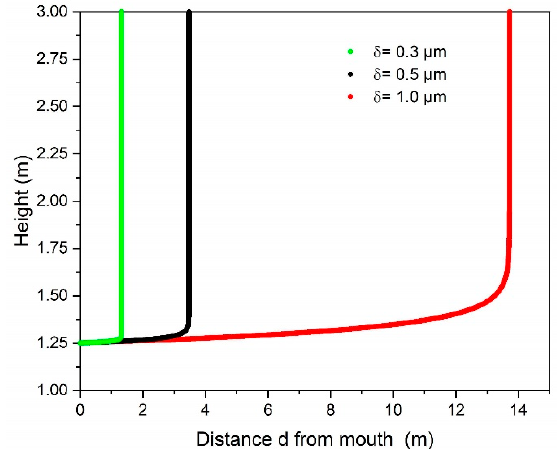
Figure 3. Trajectories of exhaled aerosol particles with different diameter before capturing by a vertical fresh air flow. The initial horizontal exhale velocity of the particles is v p , x = 2.4 m/s (10 cm from the mouth) and the vertical air flow velocity is v g , z = 0.05 m/s The material parameters used are: ρ g = 1.189 kg/m 3 , ν = 15.32 · 10 − 6 m 2 /s for air and ρ p = 914 kg/m 3 for DEHS or ρ p = 997 kg/m 3 for water, respectively. Calculations for DEHS and water aerosols give similar results.